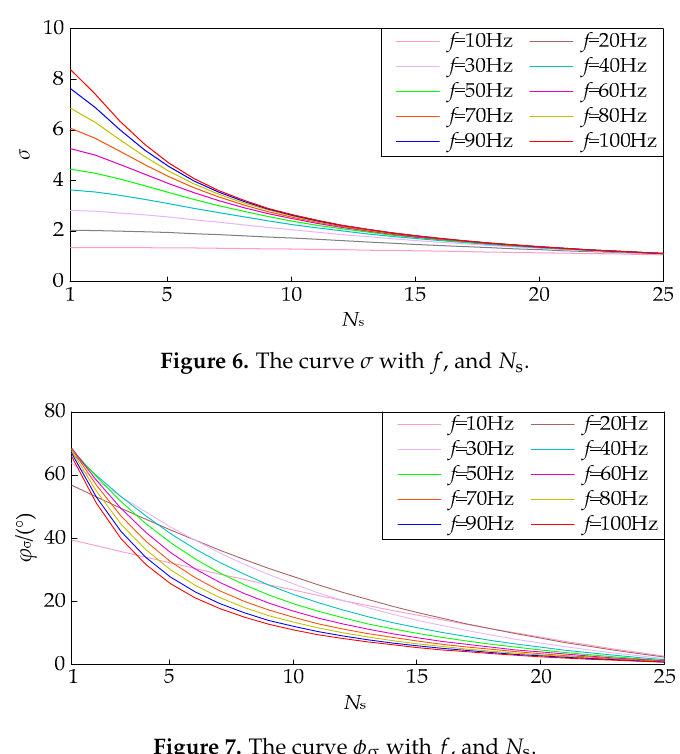
Figure 7. The curve φ σ with f , and N s .